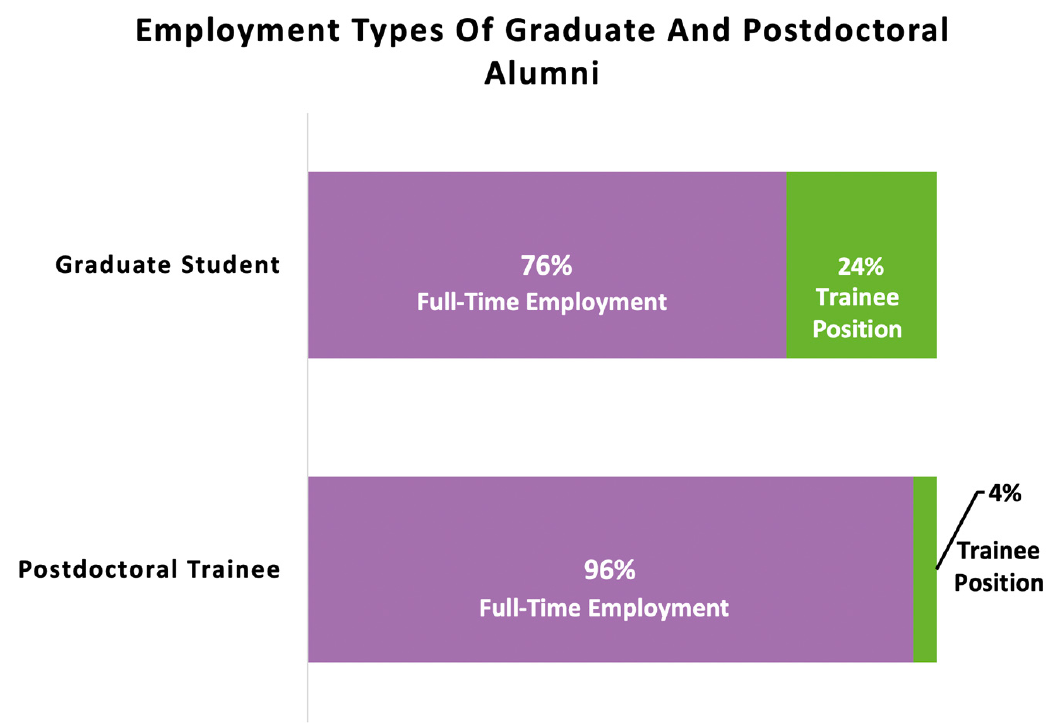
Figure 5. Percentages of graduate and postdoctoral ELITE participants hired into full-time employment vs. a trainee position. As expected, more graduate students entered into trainee positions as their next position (24%), whereas far fewer postdoctoral scholars entered into another training position